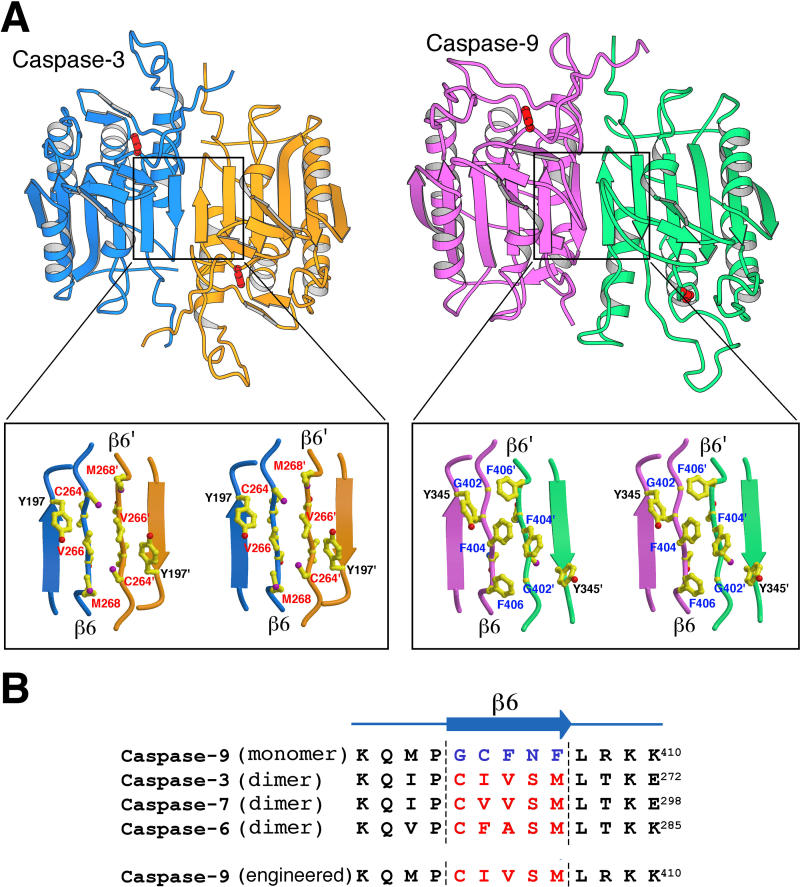
The β6 Strand Is the Major Determinant for the Dimerization of Caspases(A) Comparison of the dimerization interfaces of caspase-3 and caspase-9. Caspases-3 and -9 exist primarily as a dimer and a monomer, respectively, in solution. However, inhibitor-bound caspase-9 was crystallized in its dimeric form [19]. The overall structures of caspases-3 and -9 are similar. A close-up view of the dimerization interfaces reveals sharp variation of residues on the β6 strand between caspase-3 and -9, which likely contributes to their different propensity for dimer formation. For caspase-9, Phe404 on strand β6 appears to impede dimerization as it sterically clashes with Phe404′ of the adjacent monomer [19].(B) A sequence alignment of the residues on and surrounding the strand β6 in four representative caspases. Similar to caspase-3, caspases-6 and -7 also exist as homodimers in solution. Residues on β6 are highlighted in blue and orange for the monomeric and dimeric caspases, respectively. Note that the variation of residues on β6 strand appears to correlate with the propensity for dimerization.